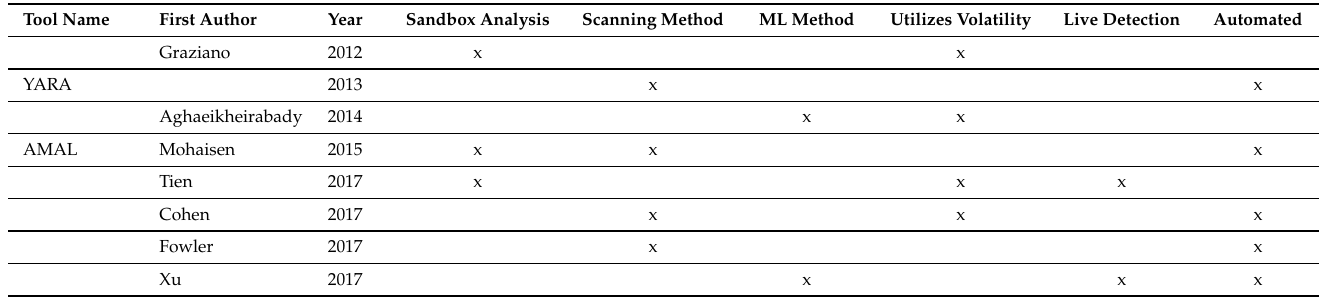
Table 2. A visual summary of the non-commercial volatile memory analysis tools. Ordered by the year the tool was released, we see the increasing popularity of ML methods. We also notice that the use of Volatility and sandboxing methods is well established. Interestingly, very few tools are capable of live malware